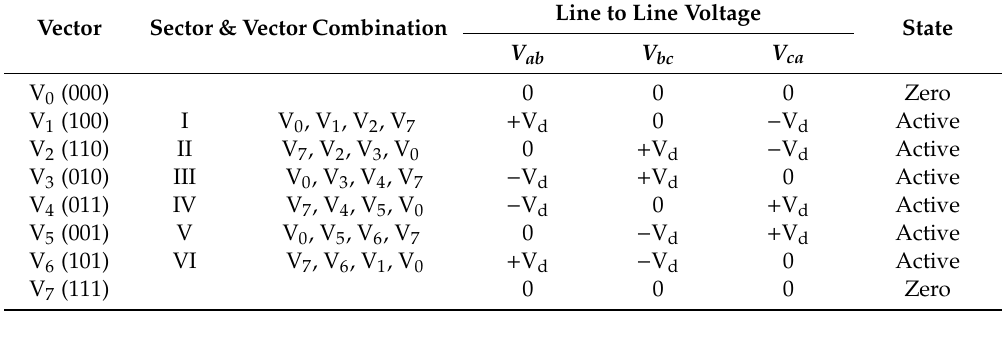
Figure 5. Vector representation of the SVM signal in sector 1 . Table 2. Space vectors state and the switching sequence.